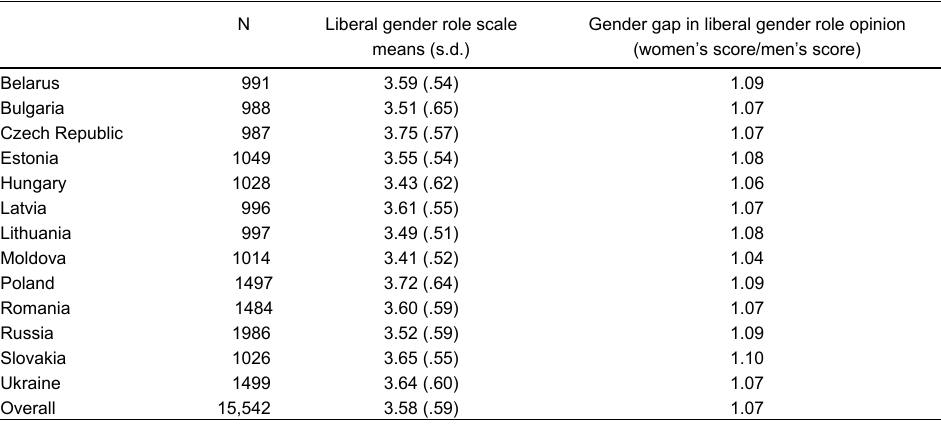
Table 1. Distribution of dependent variable across countries and overall N Liberal gender role scale means (s.d.)